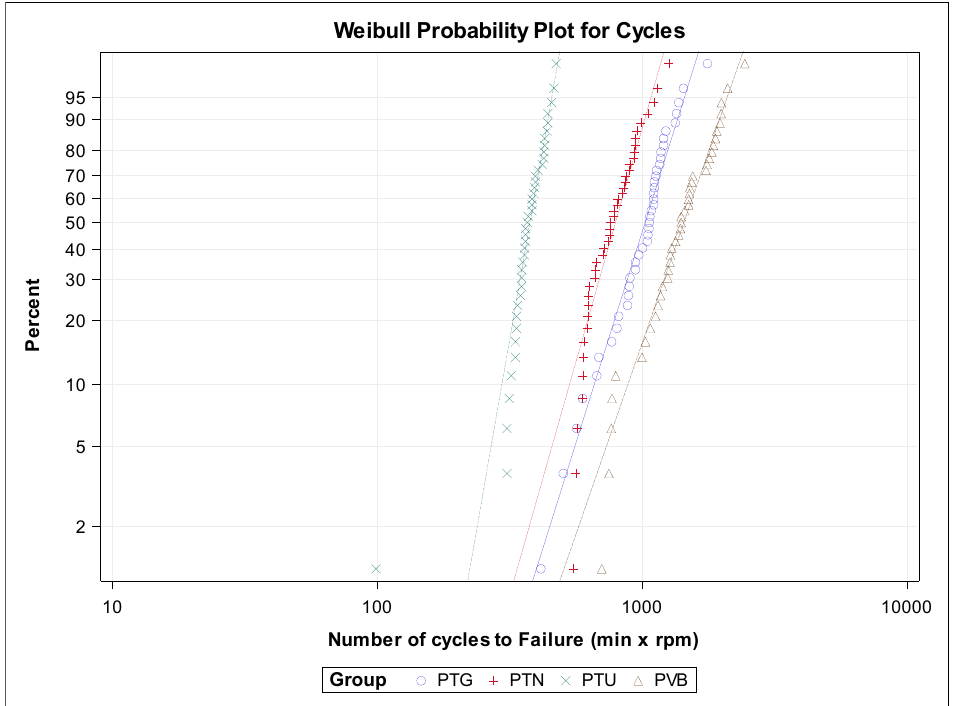
Figure 6. Weibull probability plot of the number of cycles to failure for the study groups.